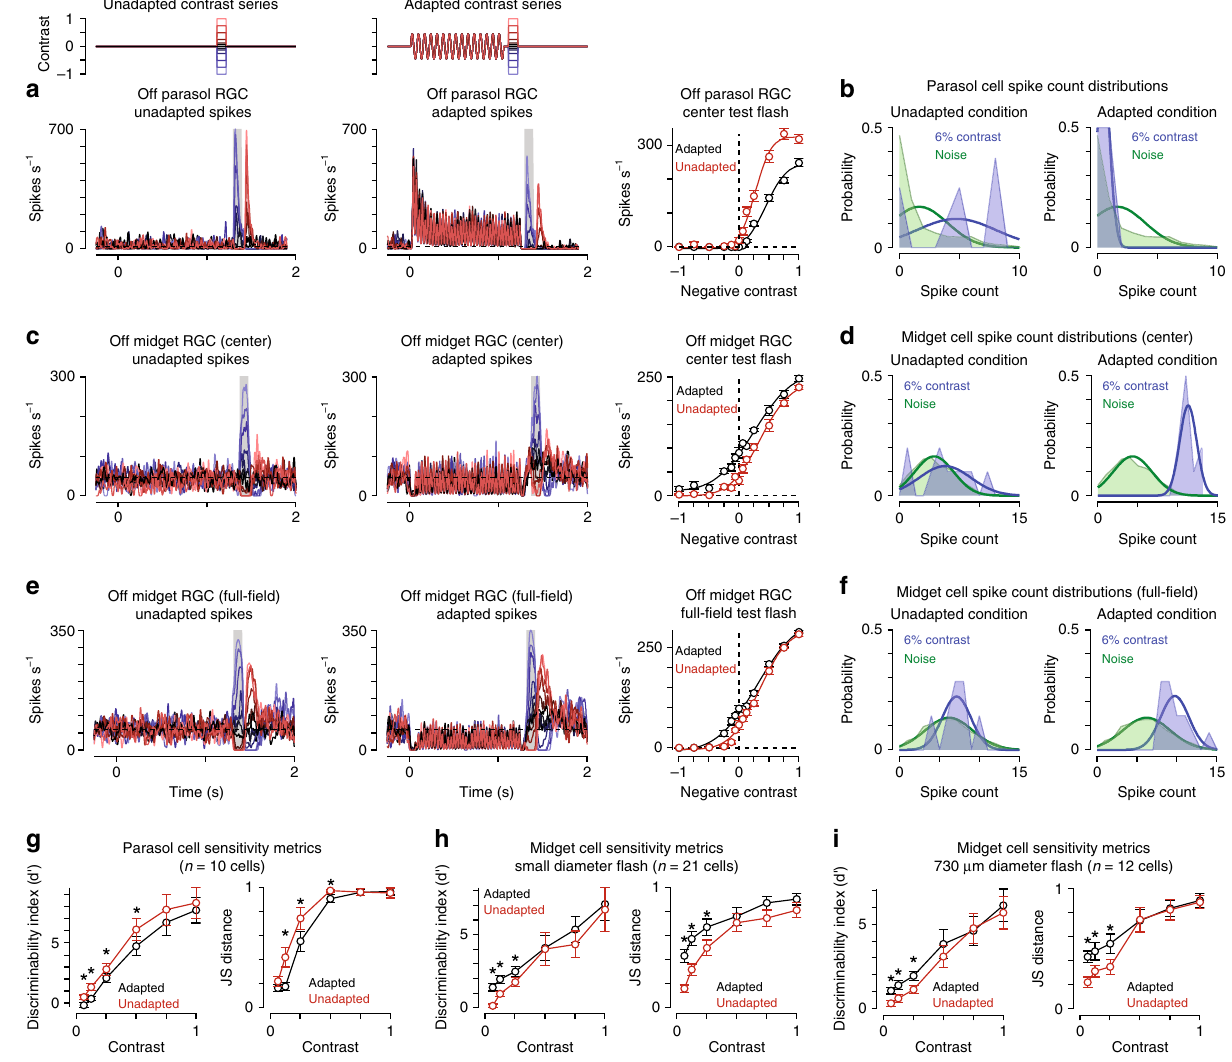
Fig. 2 Midget ganglion cells display contrast sensitization. a Spike responses from an Off parasol ganglion cell to a series of spots centered over the receptive fi eld. Spots were either presented alone (left) or 50 ms following the offset of an adapting stimulus (middle). Shaded regions indicate sampling windows. Right: Average spike rate across the shaded regions. The wide- fi eld adaptation evoked a decrease in the slope (gain) of the contrast-response curve (black) relative to the unadapted control condition (red). b Spike count distributions for the Off parasol cell in ( a ) to a − 6% contrast fl ash and the noise condition in which a fl ash was not presented (i.e., 0% contrast). The adapting stimulus decreased spiking at low contrast and shifted the low-contrast distribution toward the noise distribution (right) relative to the unadapted condition (left). c Same as ( a ) for an Off midget ganglion cell. Right: Average spike rate across the shaded regions. The wide- fi eld adaptation evoked a leftward shift in the contrast-response curve (black) relative to the unadapted control condition (red). d Same as ( b ) for the Off midget cell in ( c ). The adapting stimulus increased spike counts at low contrast, increasing the separation between the low-contrast and noise distributions. e Spike responses of an Off midget cell to wide- fi eld test fl ashes in the absence (left) or presence (middle) of the adapting stimulus. f Same as ( d ) for the Off midget cell in ( e ). g Discriminability index (left) and Jensen-Shannon distance (right) for preferred-contrast responses relative to background noise in parasol ganglion cells ( n = 10). h Sensitivity indices in 21 midget ganglion cells for small diameter test fl ashes. Discriminability index and Jensen-Shannon distance increased signi fi cantly at low contrast ( ≤ 25%) following the adapting stimulus ( p < 0.01). i Sensitivity indices in 12 midget cells for wide- fi eld test fl ashes. The adapting stimulus produced a signi fi cant increase in the Jensen-Shannon distance at low contrast (6%; p = 1.5 × 10 – 3 ). Circles and bars indicate mean ± SEM. Statistical signi fi cance calculated using the Wilcoxon signed rank